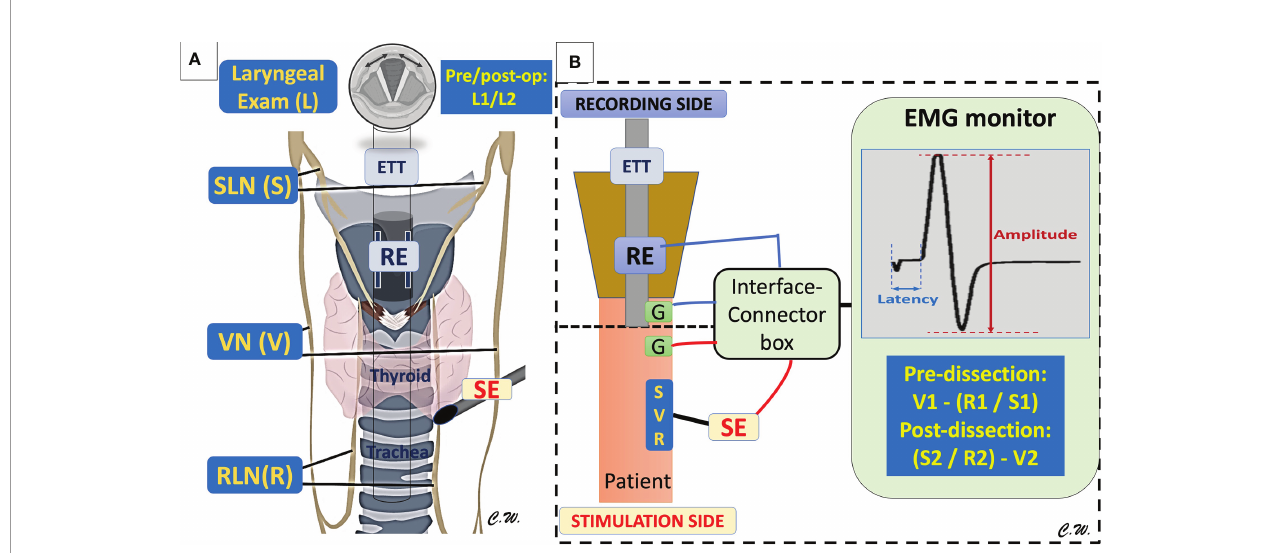
FIGURE 2 | The Basic laryngeal nerve anatomy/electrophysiology and standard monitoring equipment setup/procedures. (A) The basic equipment included the recording electrodes (RE) connected to the endotracheal tube (ETT) to place in contact with the bilateral vocal fold, the neural stimulating electrodes (SE) to stimulate the external branch of superior laryngeal nerve (SLN)(S), the Vagus nerve (VN)(V), and the recurrent laryngeal nerve (RLN)(R) during thyroid and parathyroid surgery. The standard procedure for performing IONM should include the laryngeal examination (L) before and after surgery(L1-L2), stimulating the SLN(S) before and after upper thyroid pole dissection (S1-S2), and stimulating the VN(V) and RLN(R) before and after the dissection. (B) Standard equipment setup (Recording (RE)/ Stimulation (SE) side, ground (G) electrodes, interface connector box and monitor connections. The stimulating electrode (SE) can be used for mapping, localization, and identi fi cation of the SLN (S), VN (V), and RLN (R), and the evoked laryngeal EMG waveform can be viewed on the EMG monitor screen, and the amplitude and latency changes can be monitored during